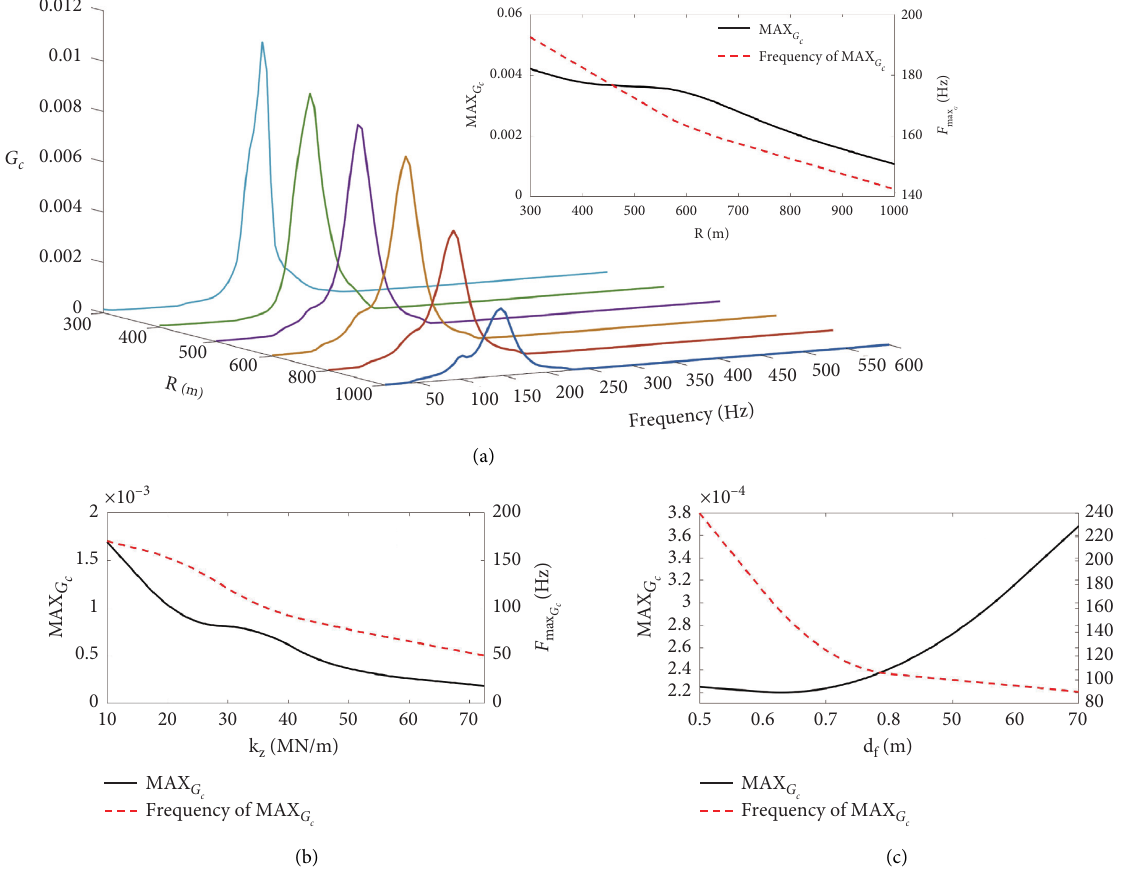
Figure 3: Sensitivity analysis results. (a) Effect of curve radius on corrugation growth. (b) Effect of support stiffness on corrugation growth. (c) Effect of sleeper spacing on corrugation